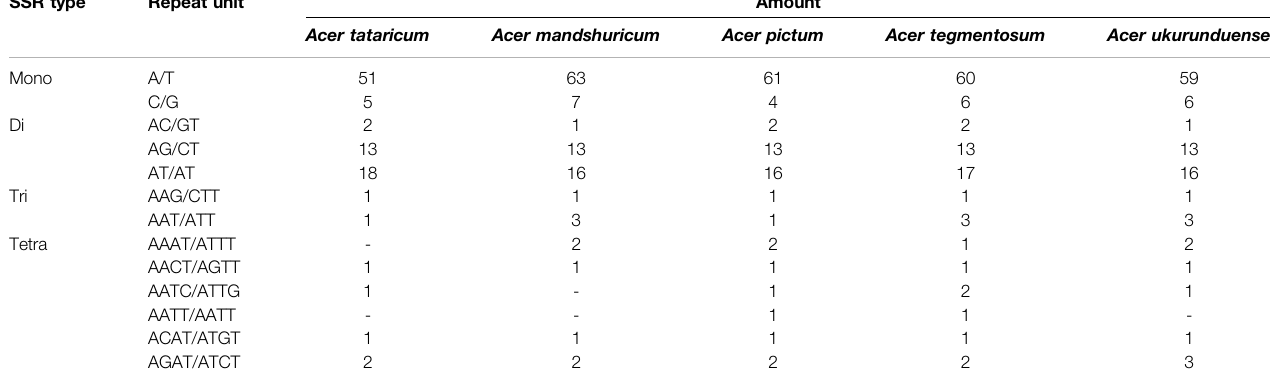
TABLE 2 | Numbers of simple sequence repeats (SSRs) in fi ve Acer cp